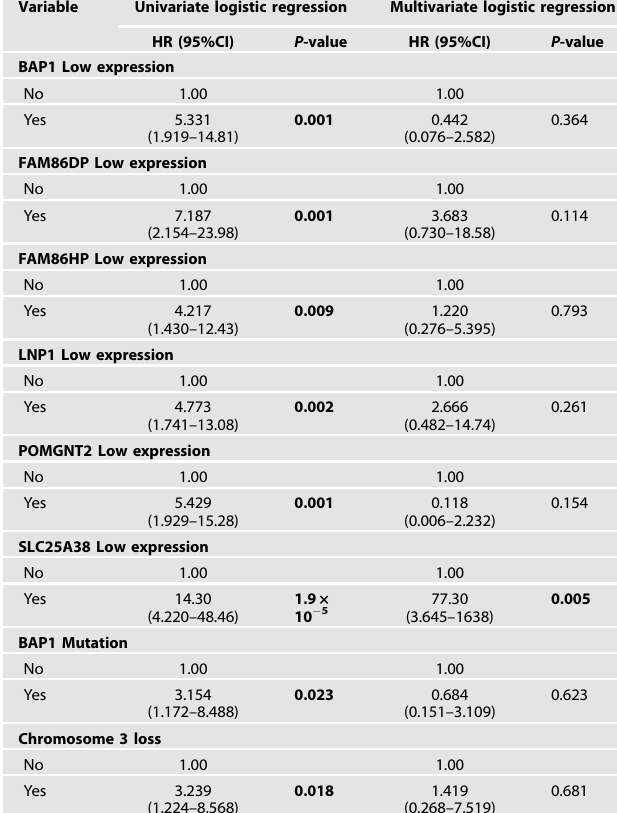
Table 1. Univariate and multivariate analysis for risk of metastasis in patients with UM by logistic regression analysis from TCGA dataset.